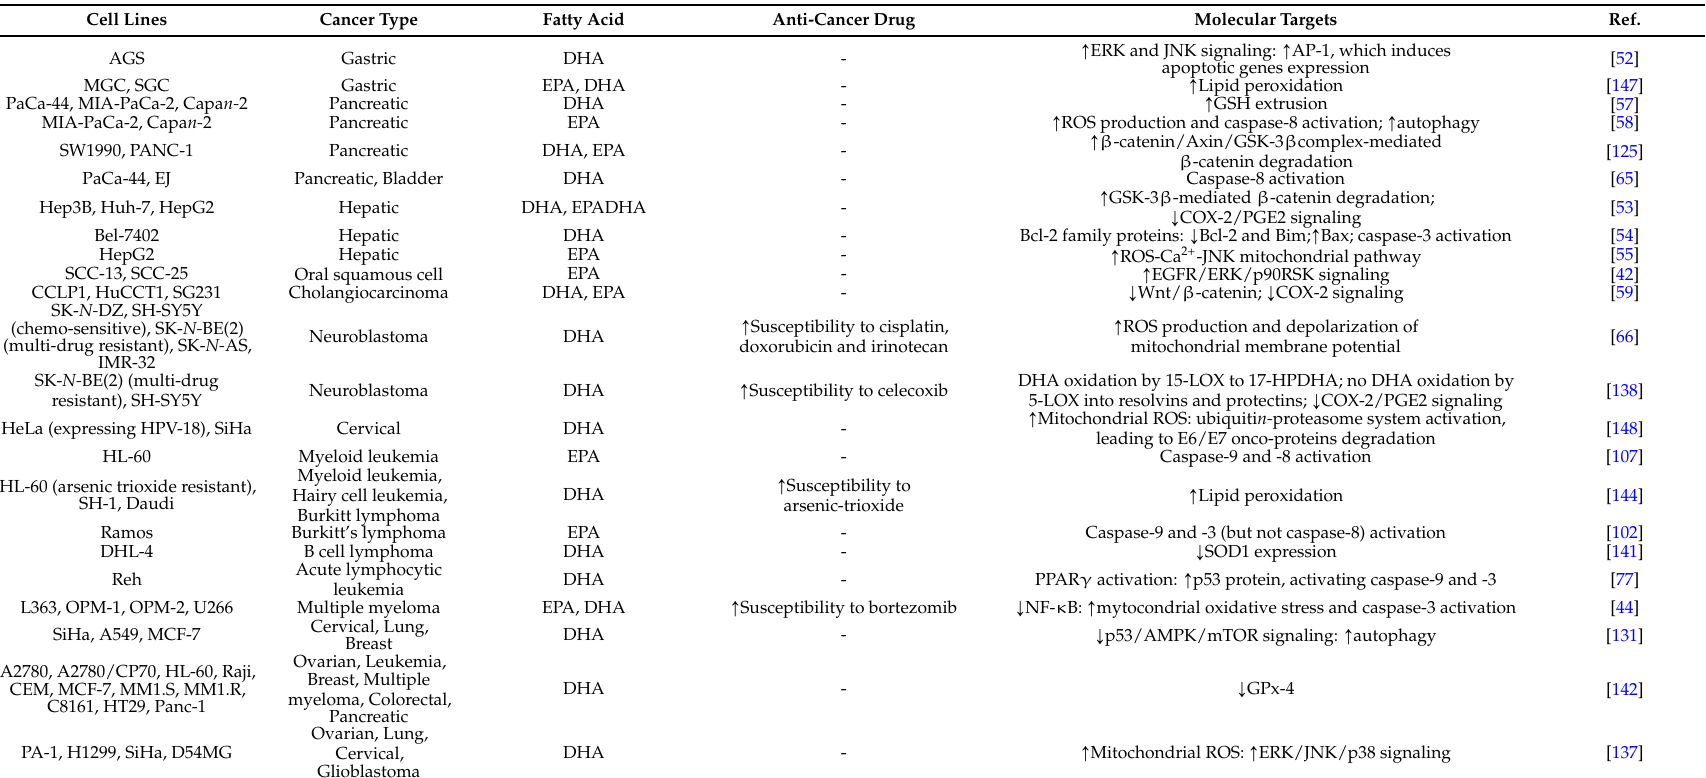
PPAR γ activation: Ò p53 protein, activating caspase-9 and